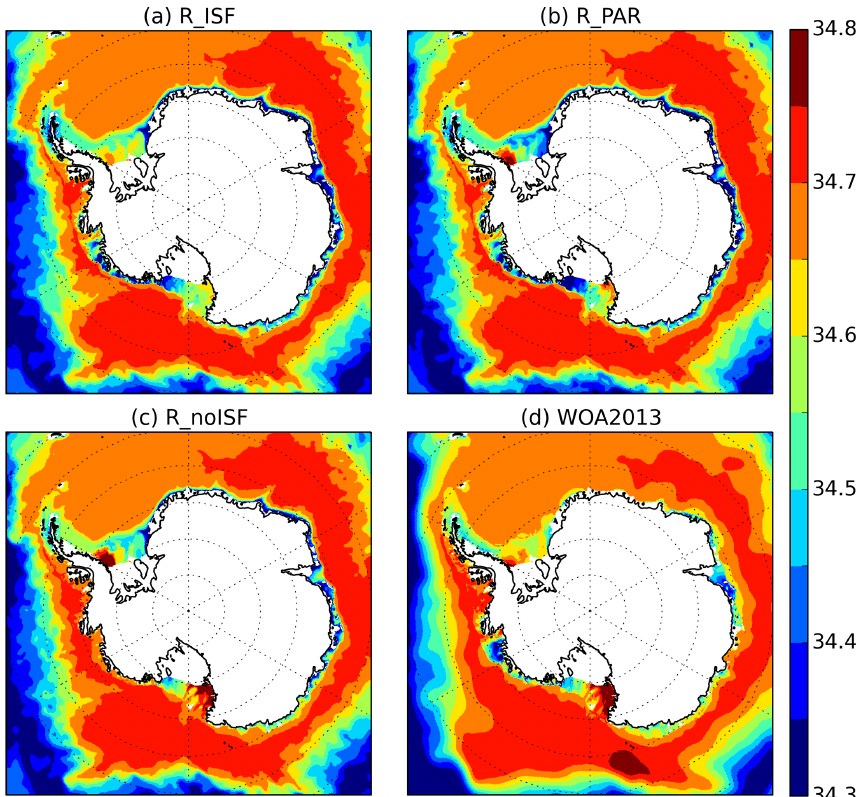
Figure 8. Salinity (PSU) averaged between 300 and 1000m (year 10, 1988) from (a) R_ISF, (b) R_PAR, (c) R_noISF and (d) World Ocean Atlas 2013 (Locarnini et al., 2013; Zweng et al., 2013).